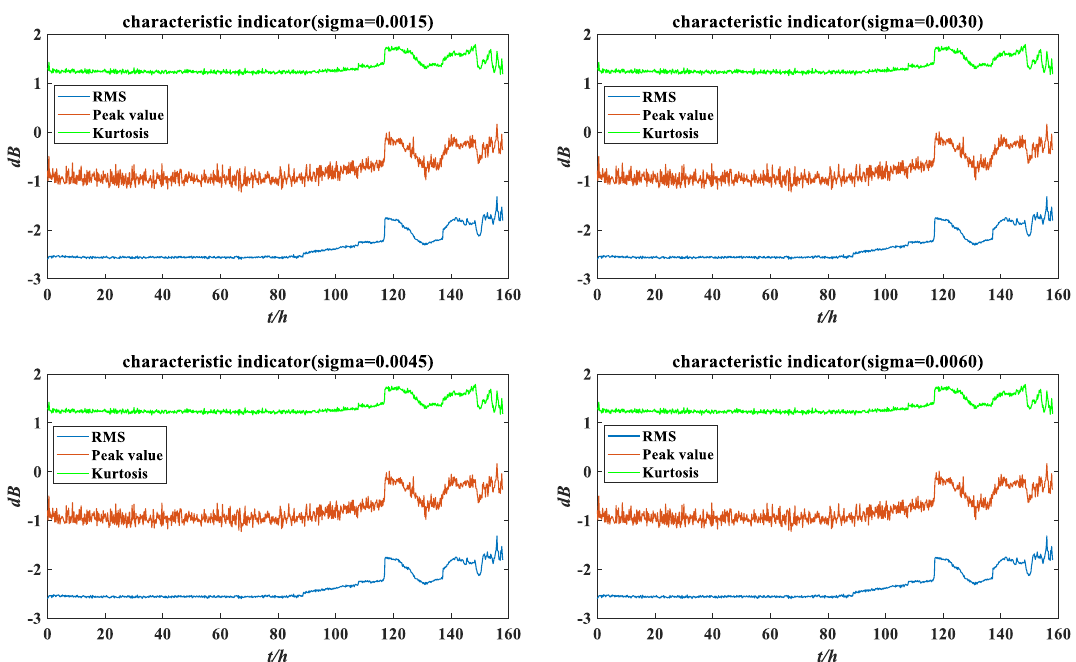
Figure 12. The characteristic indicators under different perturbation intensities.